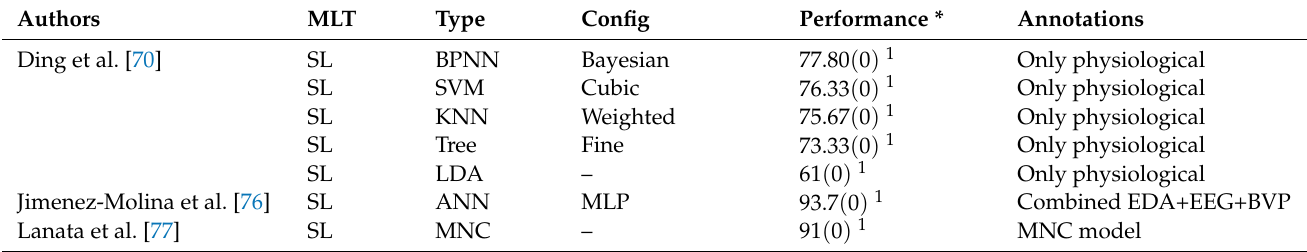
Table 16. Supervised learning methods for classification of mental/cognitive workload.